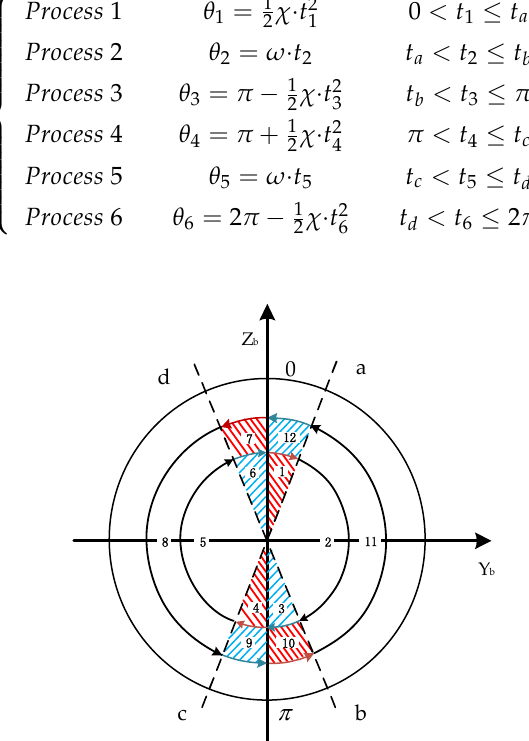
Figure 9. Diagram of the rotation sequence.